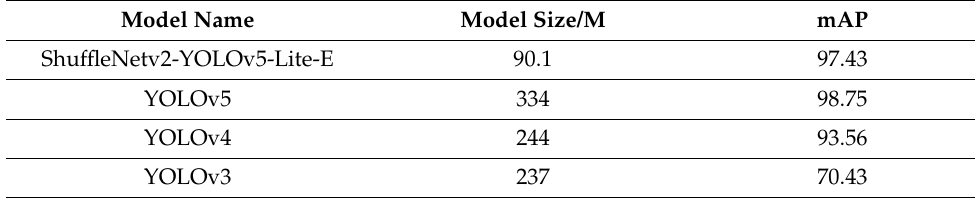
Figure 8. mAP comparison diagram. Table 1. Model size and recognition